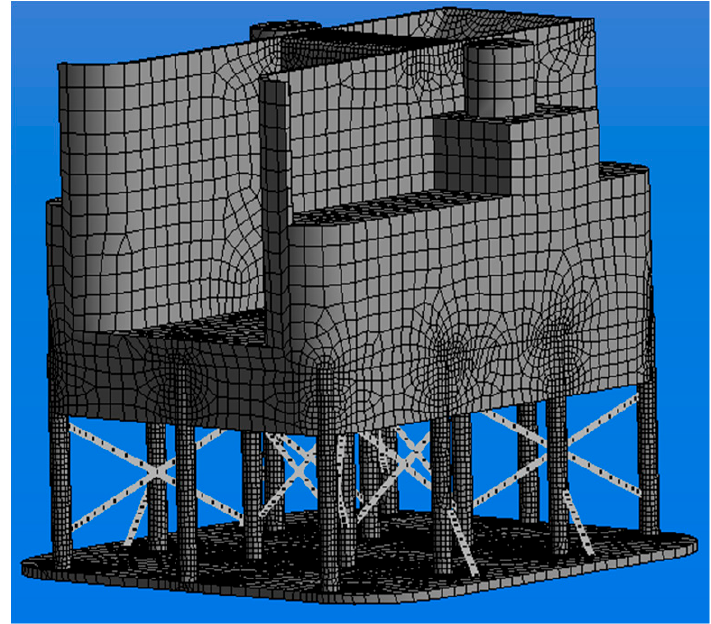
Figure 5. Meshing. Figure 5. Meshing.